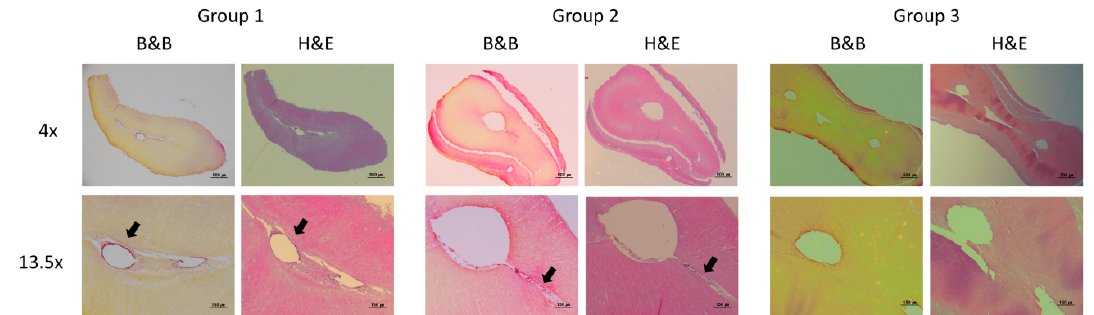
Figure 5. Representative histological images of the apical-third region from the molars left untreated (Group 1), treated with passive ultrasonic activation system (Group 2), or treated with the GentleWave System (Group 3). Note the well defined bacterial biofilm in contact with the root canal wall in Group 1 and 2 compared to Group 3.